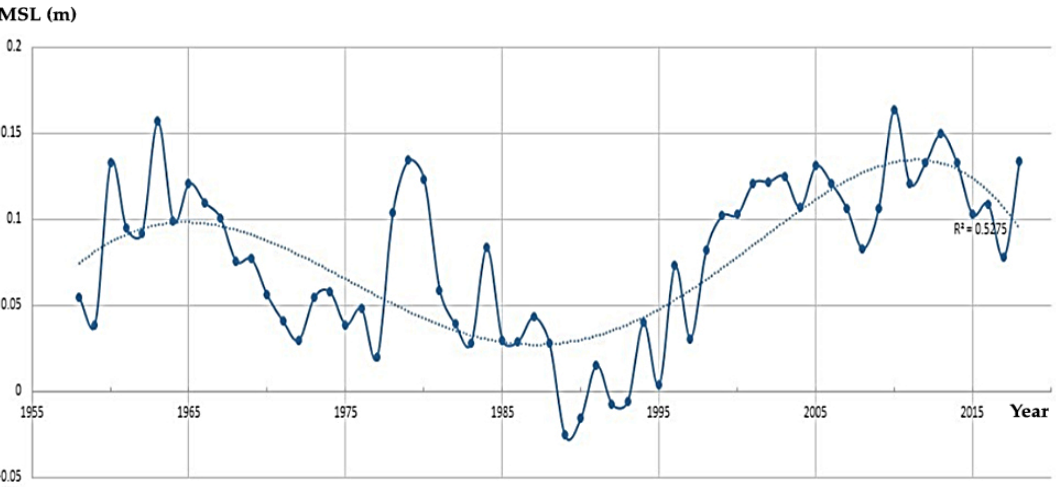
Figure 10. Mean sea level (MSL) change along the Mediterranean coast of Israel: 1958–2018. (State of Israel, Ministry of Construction and Housing, Survey of Israel).